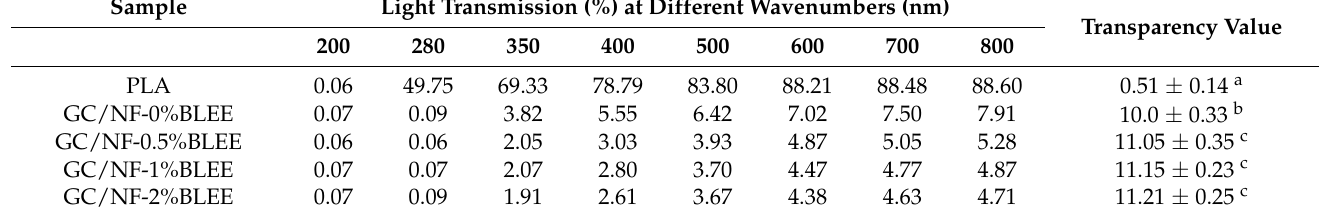
Table 2. Light transmission and transparency values of PLA film and PLA films coated with GC/NF loaded with, and without, BLEE at different